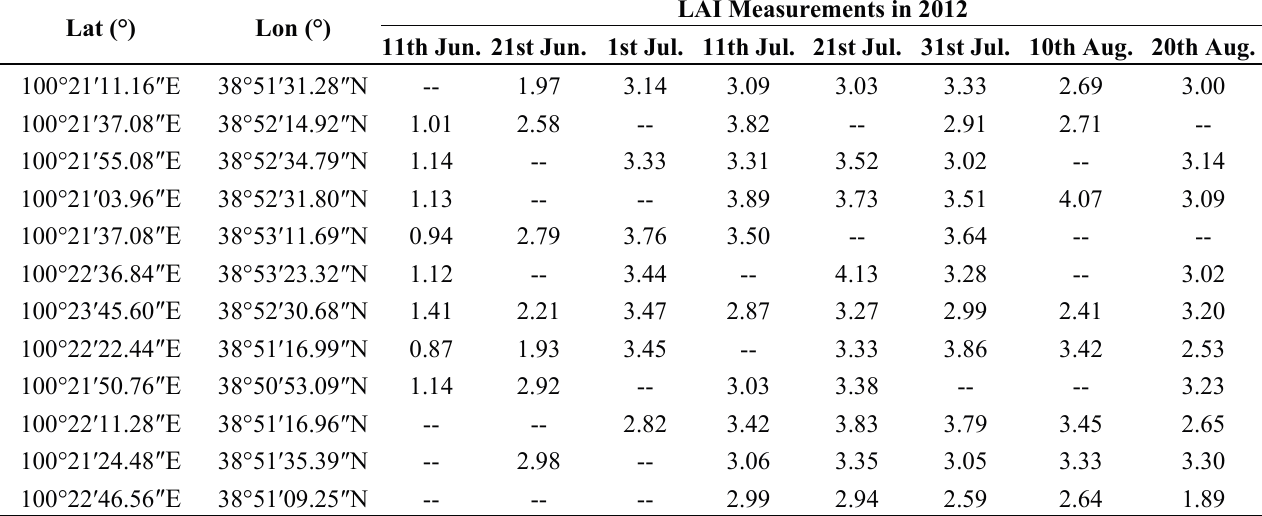
Table 2. Description of portions of the selected observation sites by WSN and LAI-2200 for LAI inversion validation obtained from 11 June to 29 August 2012. The “--” indicates “no observation data”.